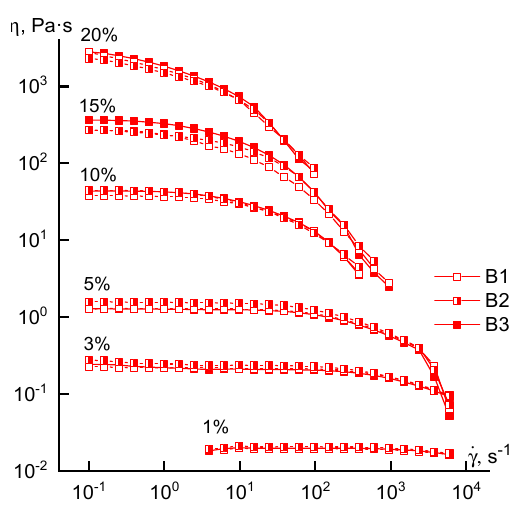
Figure 4. Flow curves of copolymer solutions of various concentrations (series B).